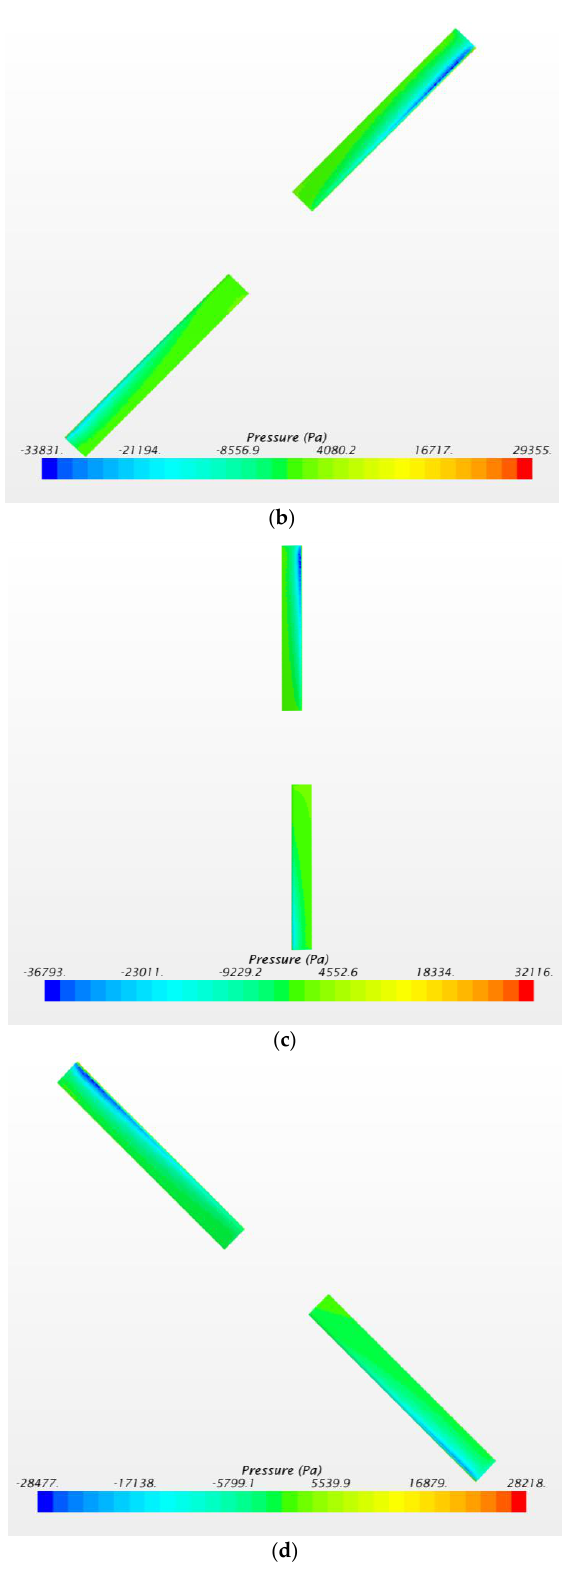
Figure 7. Pressure contours of AH-1G blades at different azimuth angles. ( a ) Azimuths of 0 and 180 degrees. ( b ) Azimuths of 45 and 225 degrees. ( c ) Azimuths of 90 and 270 degrees. ( d ) Azimuths of 135 and 315 degrees.